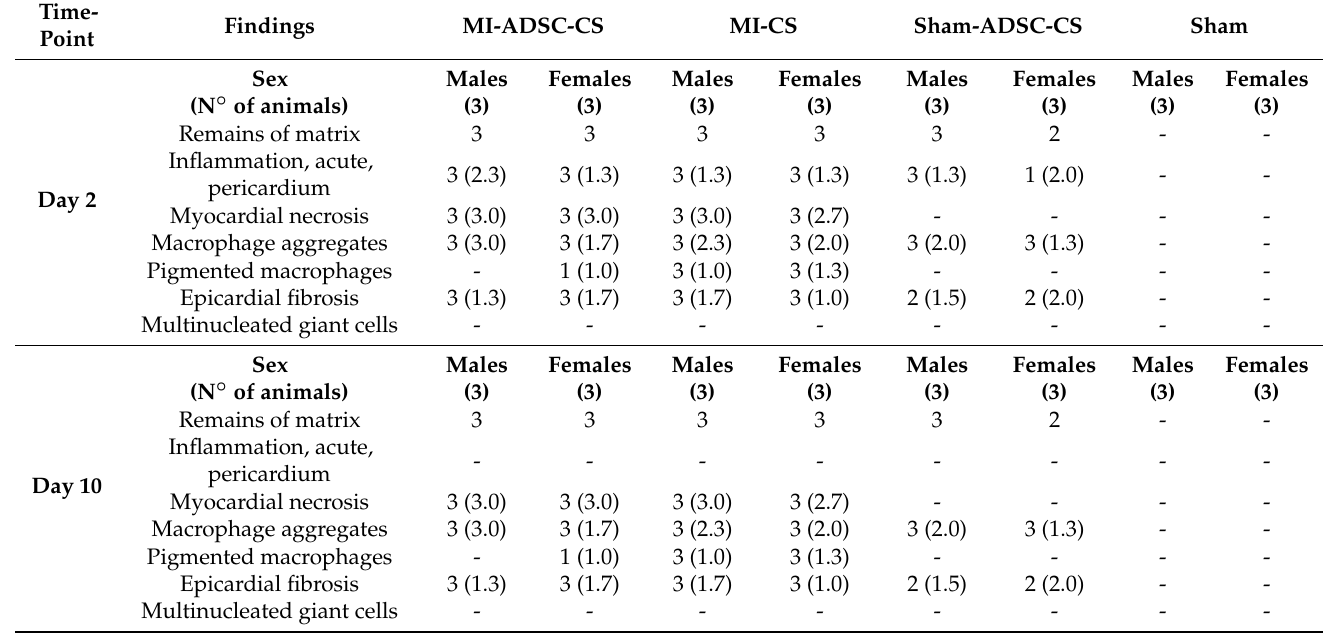
Table 1. Microscopic findings in the hearts of each group and sex. The incidence (number of rats) and average degree of severity of main findings (in brackets) are shown. The degree of severity was assessed according to the following scale: Grade 1 (minimum); Grade 2 (mild); Grade 3 (moderate); and Grade 4